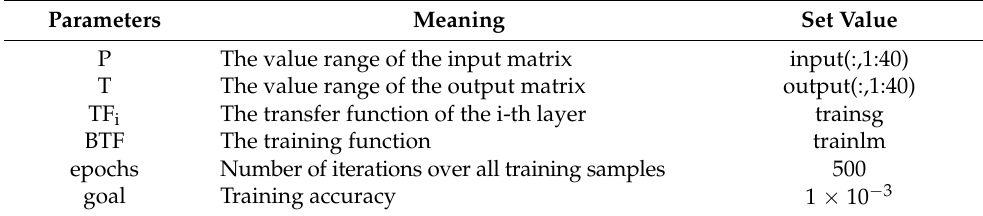
Table 3. The meaning and setting of experimental